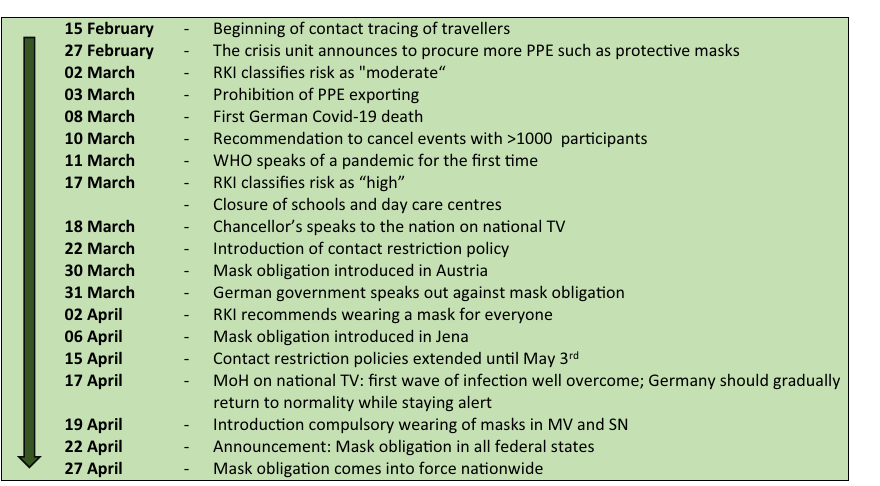
Figure 7. Timeline of communication milestones from 15 February to 27 April